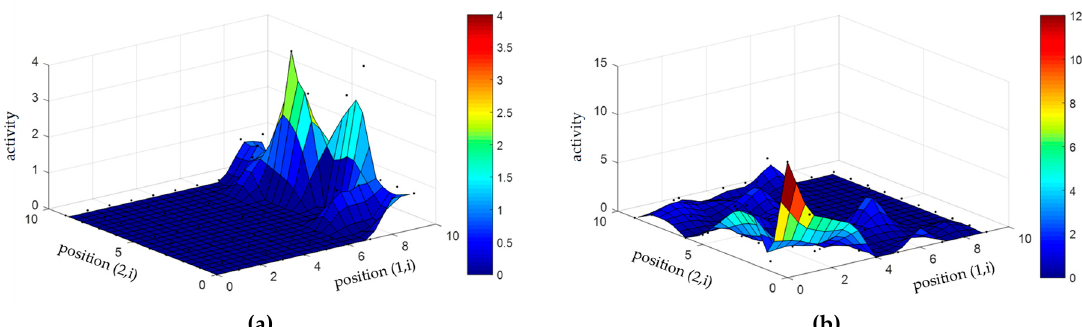
Figure 16. Active areas of the 10 × 10 Kohonen map in the case of an undamaged bearing ( a ) and with a fault ( b ) for the neighbourhood radius equal to 2 and the linkdist function.